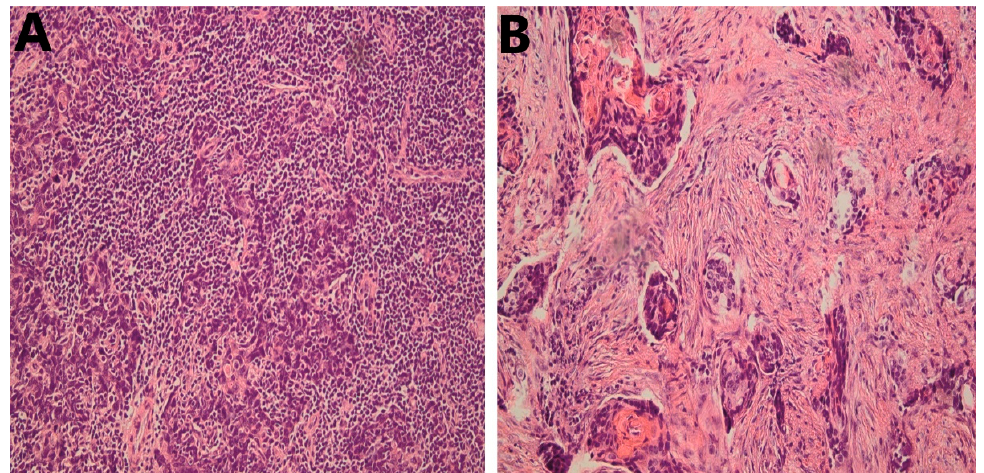
Figure 2. Representative cases of HNSCC stained with HE; 20×. ( A ) High infiltration of stromal TILs; ( B ) Low stromal TILs; 20×. HNSCC, head and neck squamous cell carcinoma; HE, hematoxylin and eosin; TILs, tumor-infiltrating lymphocytes.